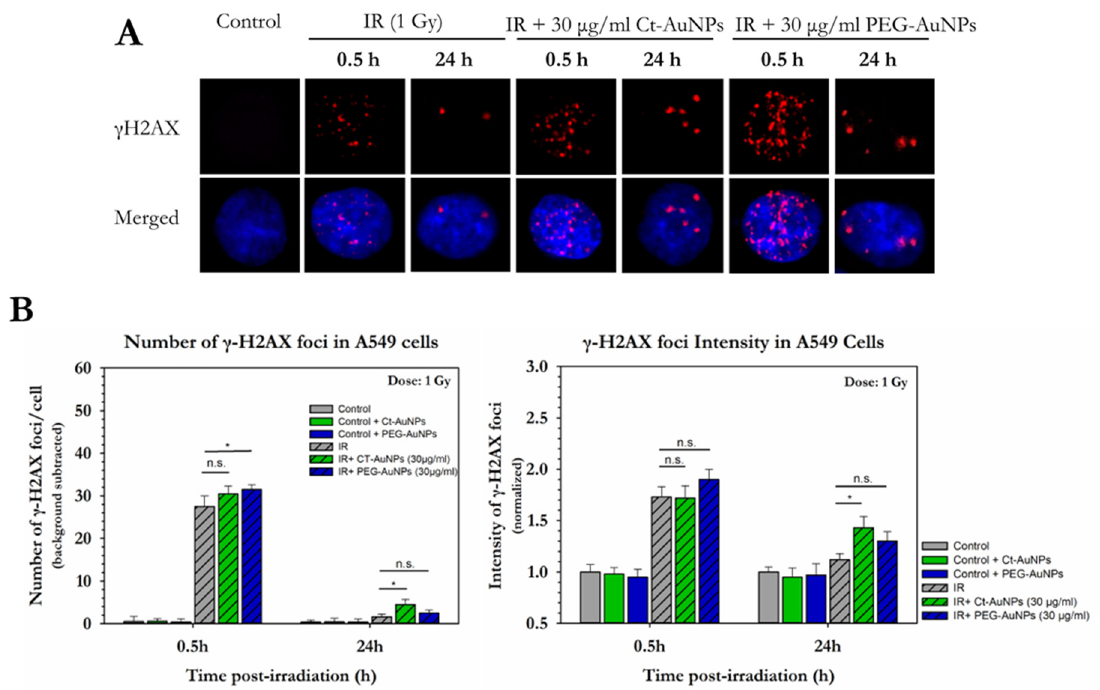
Figure 8. Quantitative and qualitative representation of DSBs in A549, after AuNP-induced radiosensitization with 1 Gy 320 KVp X-rays. ( A ) The nucleus is stained with DAPI, shown in blue, and the marker for DNA DSBs ( γ H2AX) is shown in red. ( B ) Figures show the average number of γ H2AX foci as well as the normalized foci intensity counted 0.5 h and 24 h after exposure. Statistical significance was determined using Student t test: * p ≤ 0.05, n.s.: not significant.